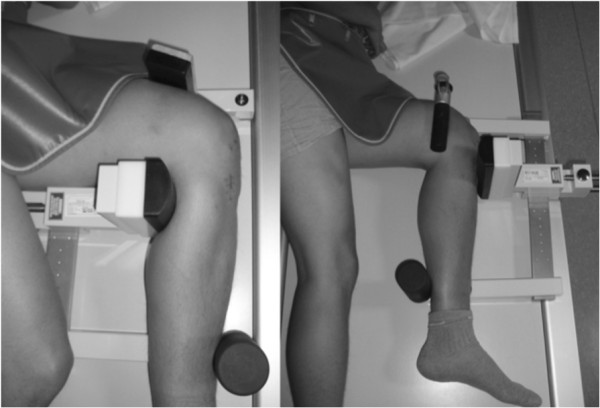
The patient is positioned in the Telos stress device to the anterior stress (left) and the posterior stress (right) with an applied load of 20 kp, described by others [34],[35].